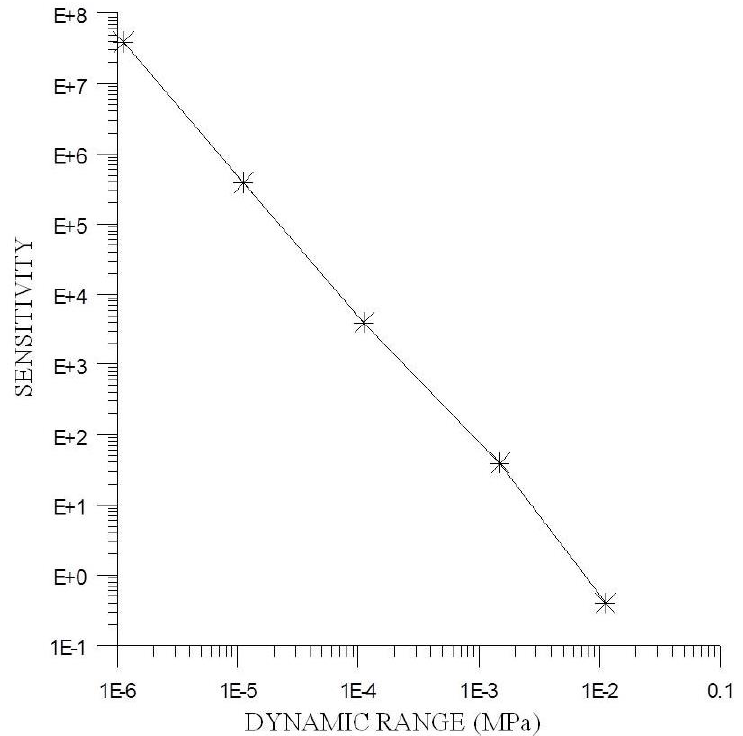
Figure 2. Sensitivity vs. dynamic